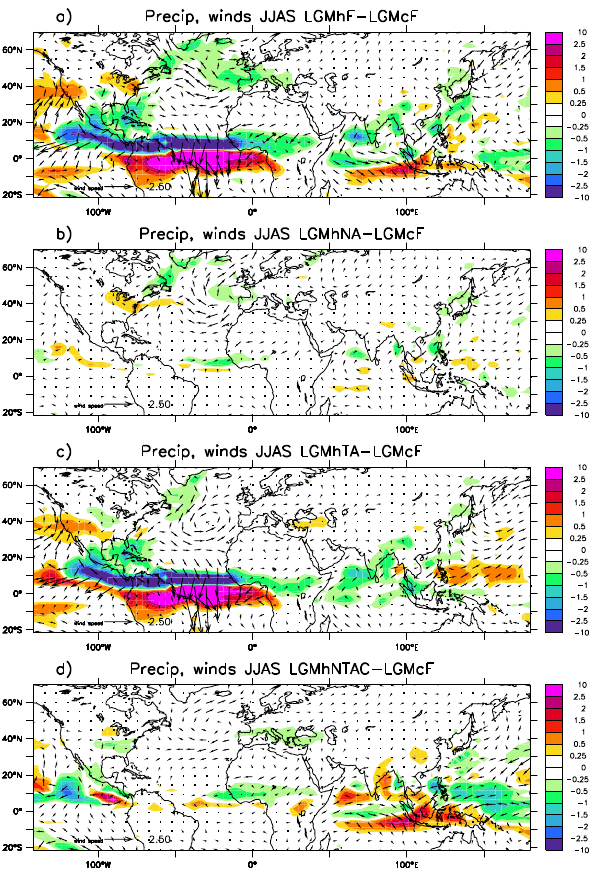
Fig. 7. Differences of JJAS 200hPa geopotential and winds between (a) LGMhF and LGMcF, (b) LGMhNA and LGMcF, (c) LGMhTA and LGMcF, (d) LGMhNTAC and